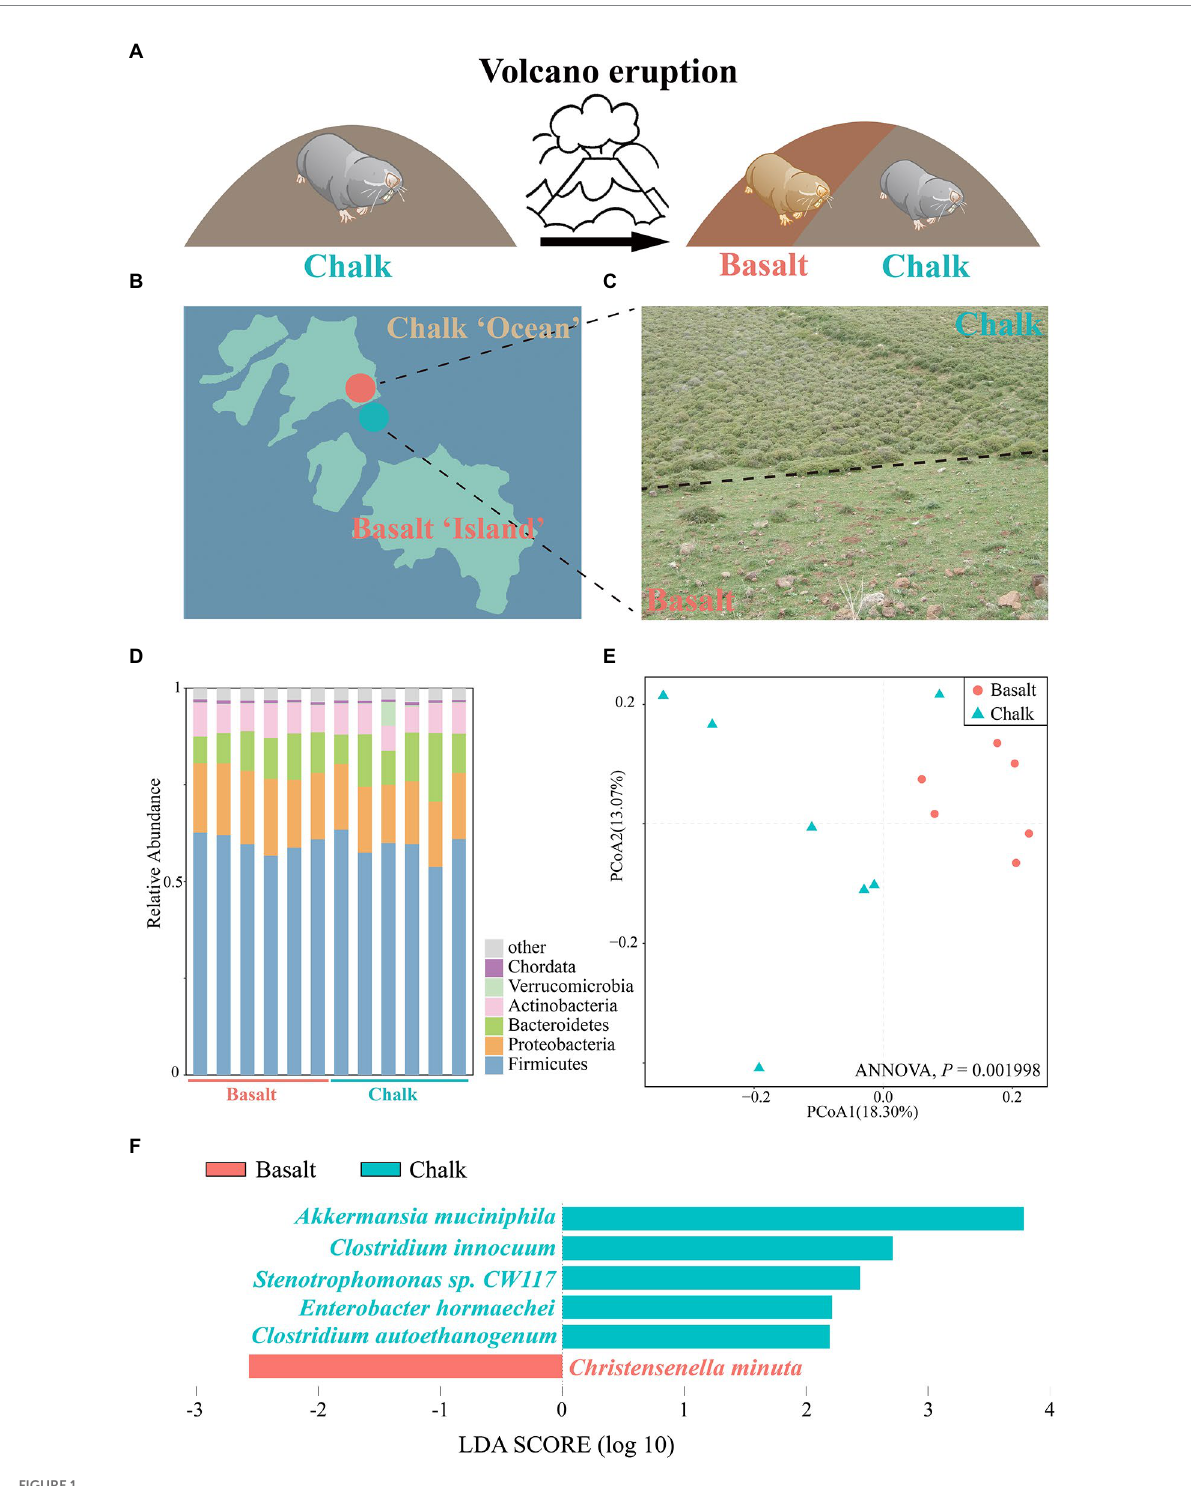
FIGURE 1 Abutting but different environments and the gut microbiome composition. (A) Volcanic eruptions have led to the formation of new habitats and new populations of Basalt. (B) Geological map including the Senonian chalk soil and the abutting derivative Plio-Pleistocence basalt soil, which is like reddish basaltic islands in pale chalk ocean. (C) Habitat-specific photographs and the contrasting plants with only 28% of the same in the abutting different soils. (D) Barplot of Bacteria composition, which showed that the most abundant phyla are Firmicutes and Proteobacteria. (E) Principal coordinates analysis (PCoA) based on the relative abundance of MAGs showed samples from basalt clustered together and samples from chalk were in one cluster. (F) Species with significant differences in chalk and basalt, identified by